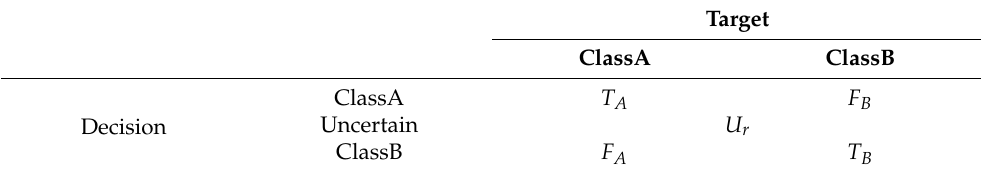
Table 1. Confusion matrix of two-classes classification.